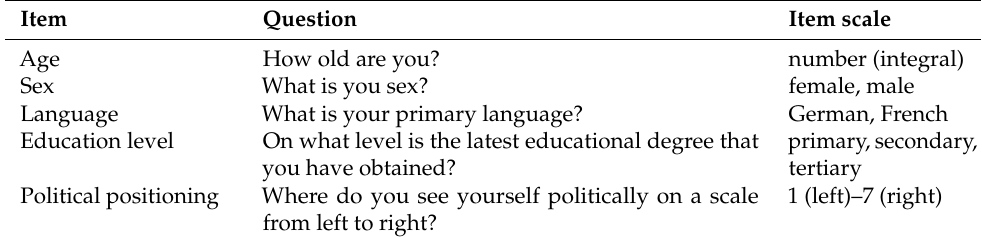
Table 5. Control variables for the